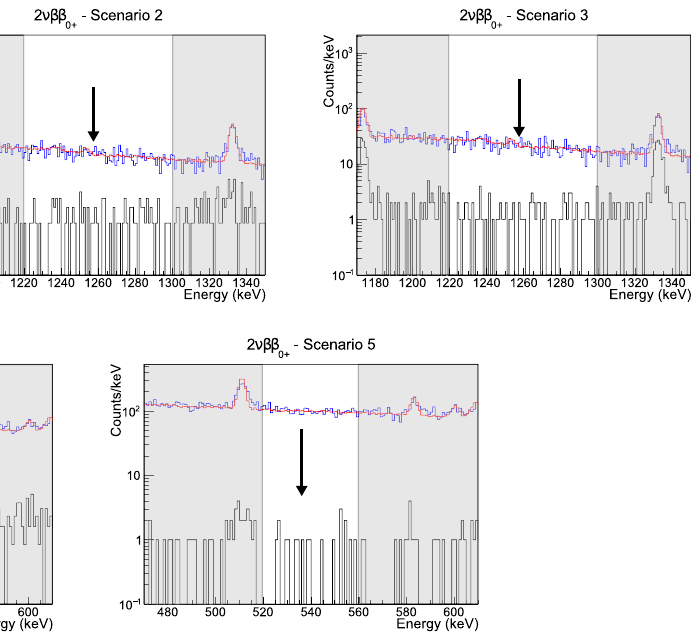
in black are data with energy cuts. The non-shaded area represents the fit range, while the black arrow points to the location of the expected